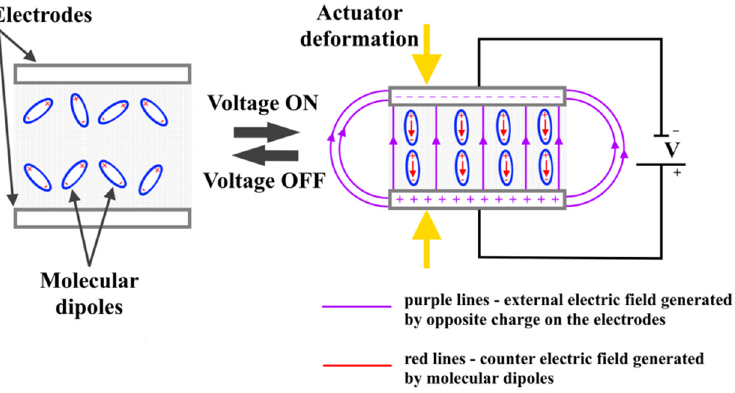
Figure 4. Polarization process of molecular dipoles of elastomer films under an external electric field. DE actuators can have different configurations of deformation, such as spiral, cone, reel, and rhombus, which are related to the generated types of movements: compression; elongation; bending; and rotation; Figure 5.